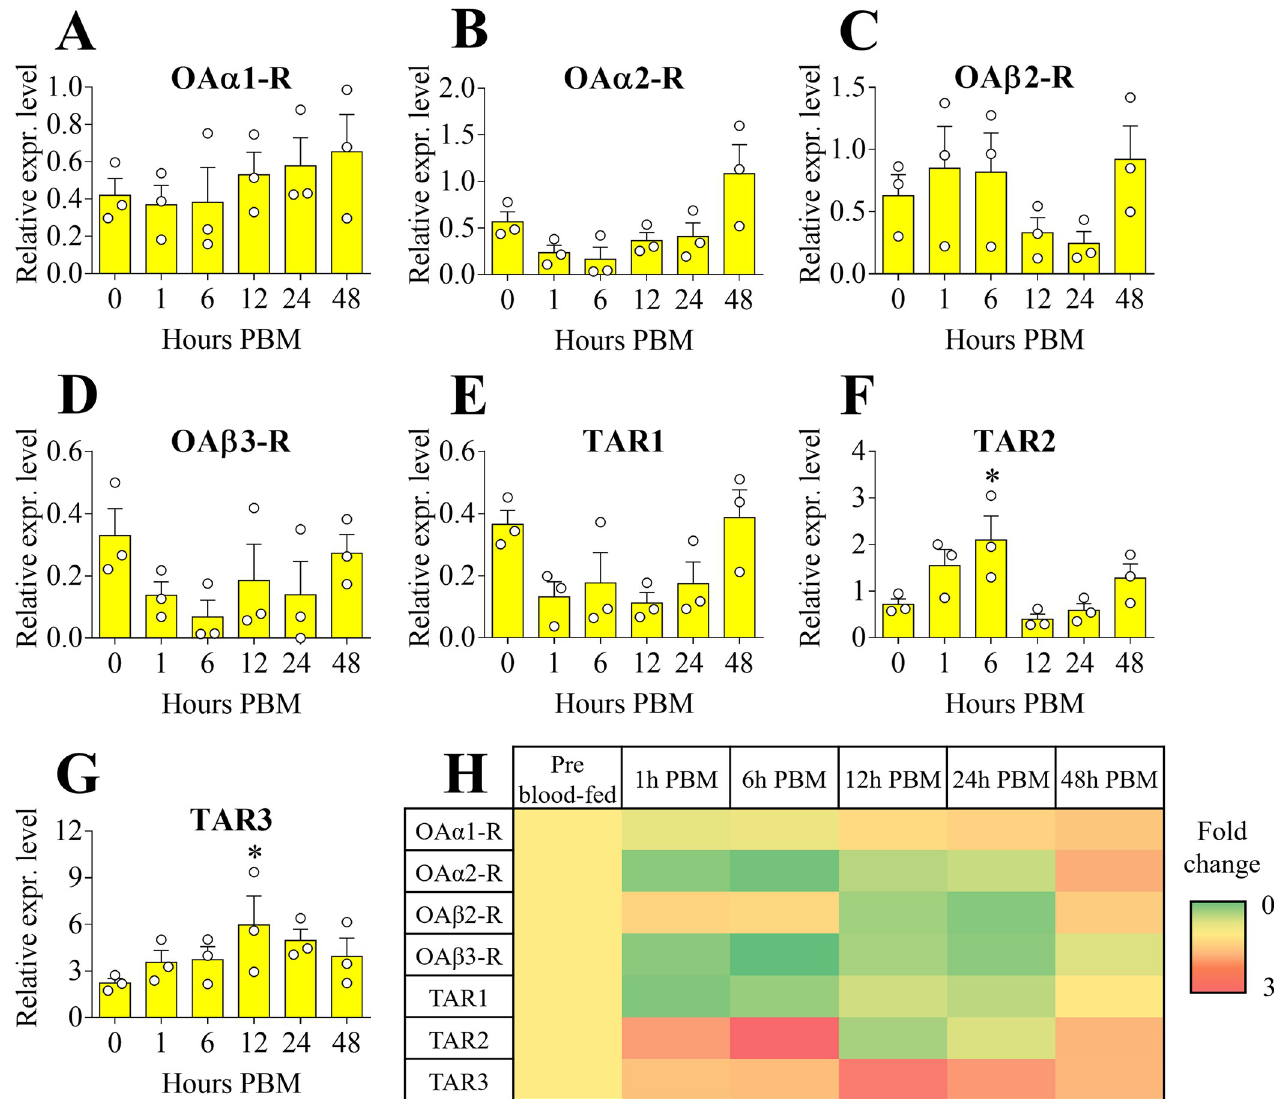
Fig 6. Expression patterns of OA and TA receptor transcripts among female adult A . aegypti Malpighian tubules post blood meal (PBM) time points. AaOA α 1-R ( A ), AaOA α 2-R ( B ), AaOA β 2-R ( C ), AaOA β 3-R ( D ), AaTAR1 ( E ), AaTAR2 ( F ) and AaTAR3 ( G ). Setting all the receptor expression levels in pre blood-fed condition to 1, a heat map was assembled ( H ). Data represent means ± SEM of three biological replicates. � p < 0.05 vs pre blood-fed conditions (0 hours PBM) according to one-way ANOVA followed by multiple comparisons Bonferroni post hoc